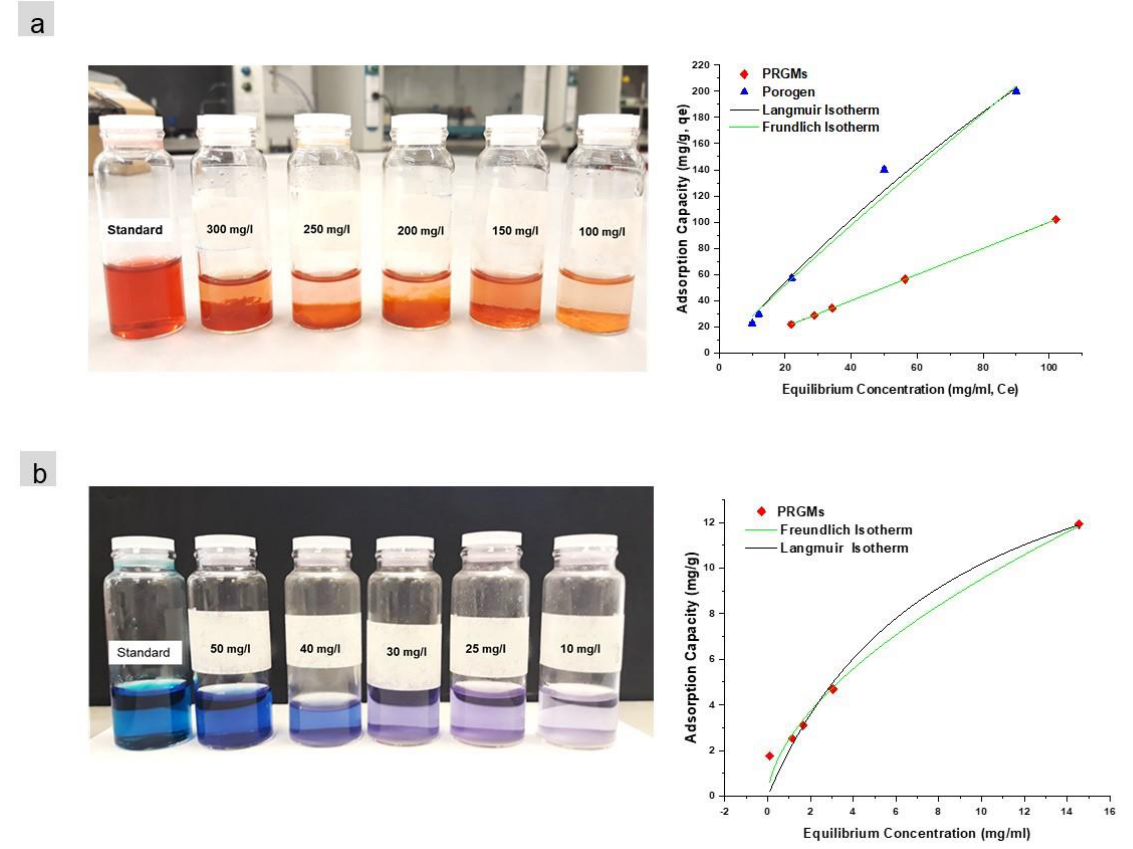
Figure 4. Isotherm data fitted with Langmuir and Freundlich models for ( a ) AR88 and ( b ) MB dye. (PRGMs dose = 5 g/L, pH 2.5 and pH 10 for AR88 and MB respectively and temperature of 22 ± 2 °C equilibrium time 24 h). Table 2. Isotherm constants for adsorption of AR88 and MB.